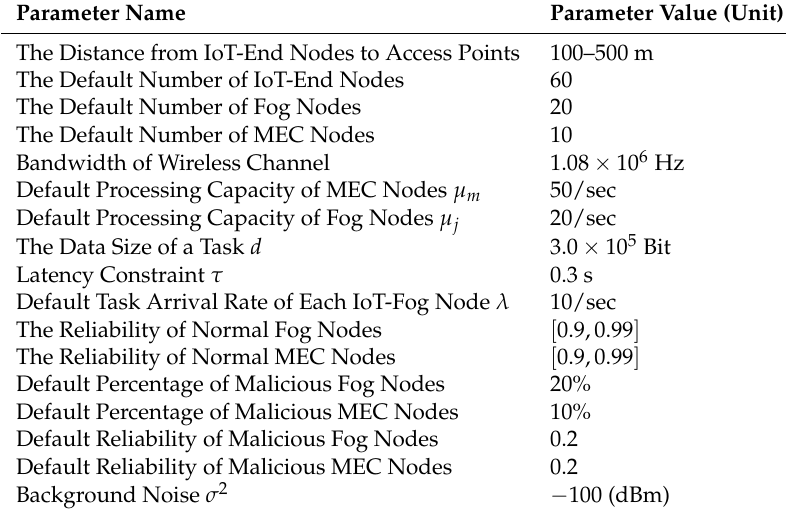
Table 3. Simulation Parameters.